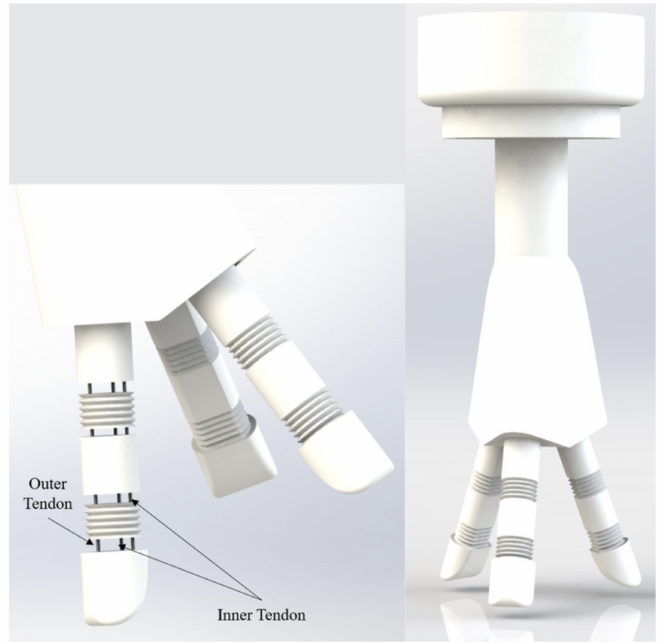
Figure 4. Illustration of the variable-stiffness structure in the soft gripper.